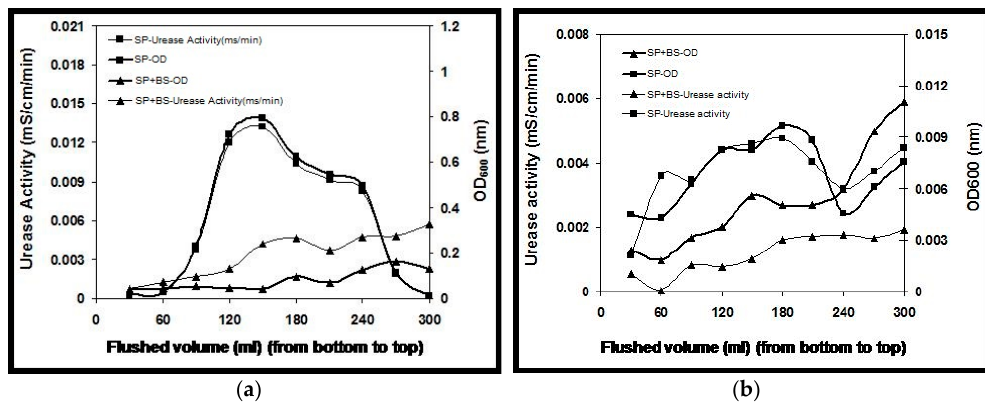
Figure 1. ( a ): Effluent measurements for two columns, i.e., monoculture S. pasteurii and coculture S. pasteurii and B. subtilis after flushing 0.05 M CaCl 2 ; ( b ): Effluent measurements for two columns, i.e., monoculture S. pasteurii and coculture S. pasteurii and B. subtilis after flushing cementation solution of 1.1 M Urea and CaCl 2 .